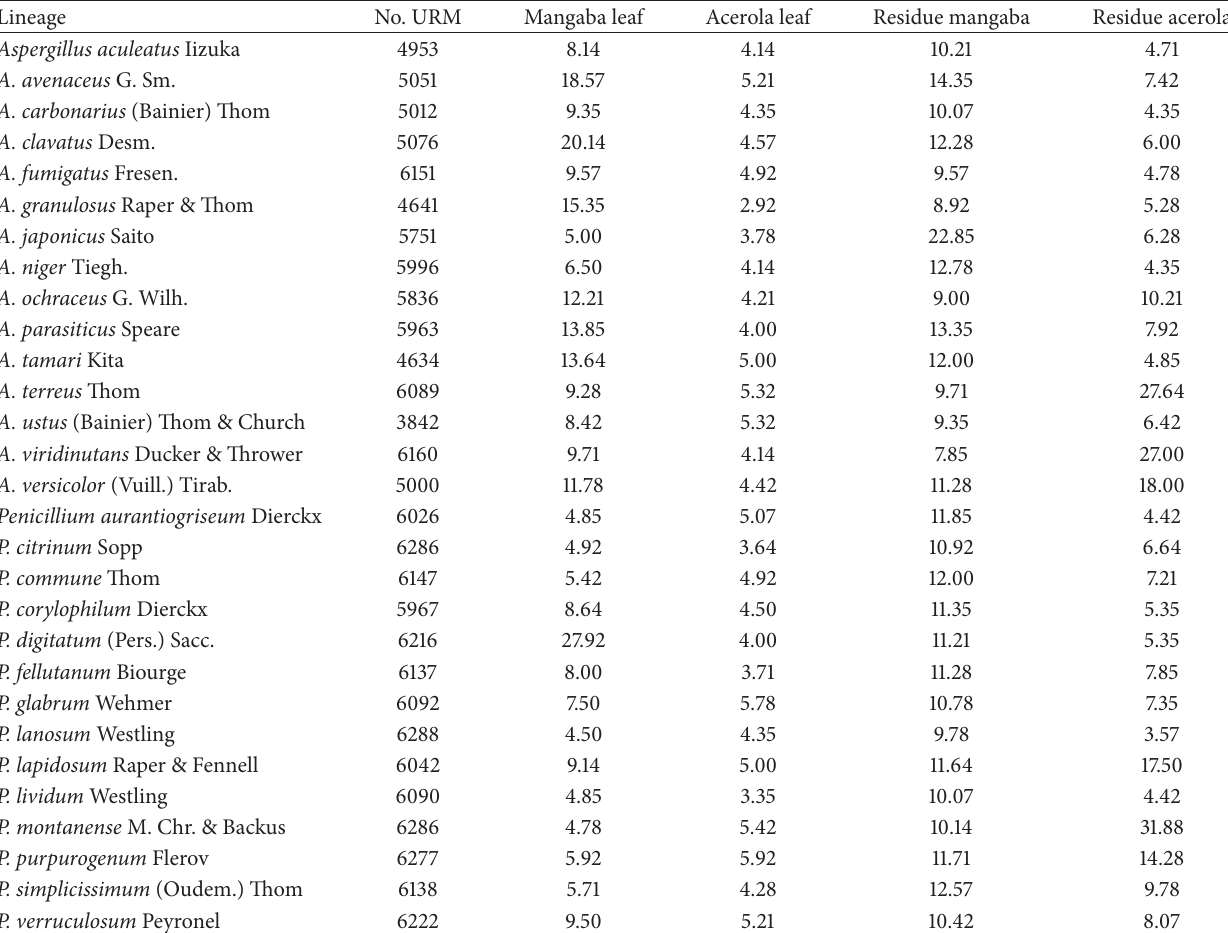
Table 2: Tannase activity (U/mL) strains of Aspergillus and Penicillium produced under solid state fermentation (SSF) using agroindustrial waste and leaves of barbardos cherry ( Malpighia emarginata ) and residue and leaves of mangaba fruit ( Hancornia speciosa Gomez) as substrates after 96 hours of